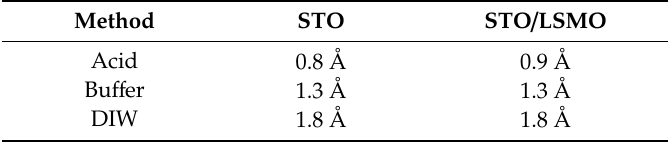
Table 1. The roughness of the di ff erently prepared samples measured by